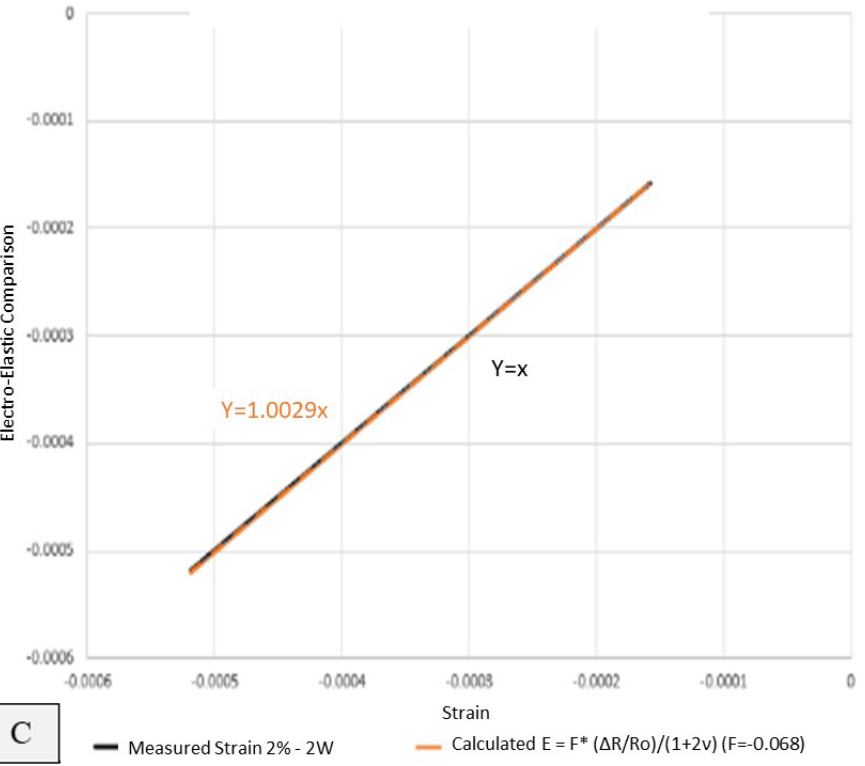
Figure 11. Elasto-Electric Relations for Load Test 1 of Left Electrode ( A ), Middle Electrode ( B ), and Right Electrode ( C ) Pairs.